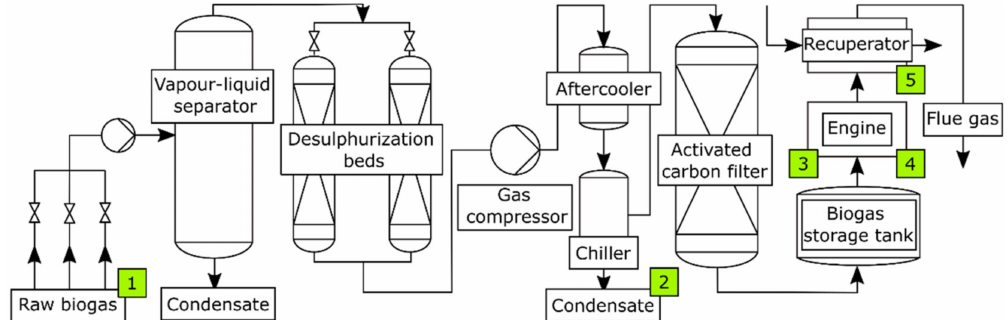
Figure 1. Biogas purification system: 1—biogas before purification, 2—condensate, 3—engine deposits, 4—oil, 5—recuperator